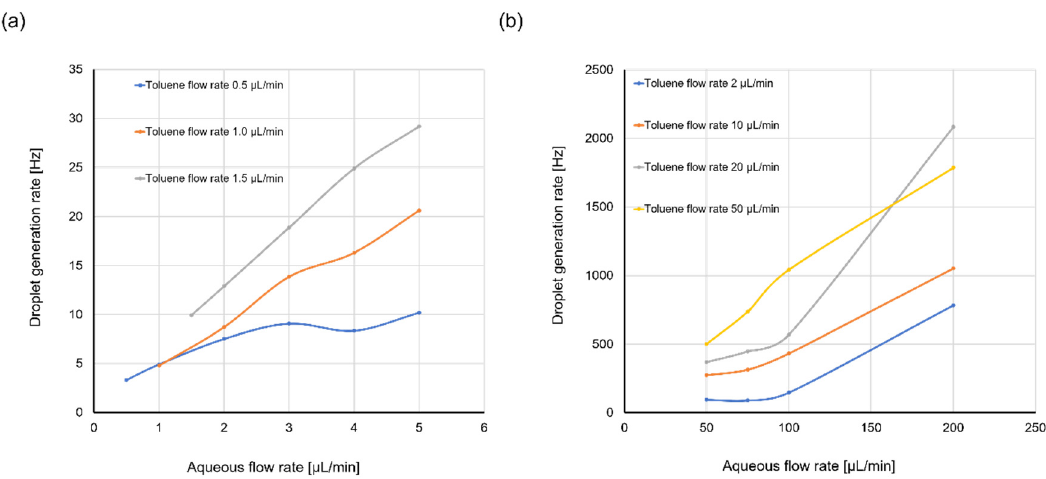
Figure 5. Variation in toluene droplet generation rate under different flow rates of dispersed phase (toluene) and continuous phase (water containing 4 wt % Tween 20). ( a ) The toluene flow rate was 0.5, 1.0, or 1.5 µL/min, and the aqueous flow rate was 0.5, 1.0, 1.5, 2.0, 3.0, 4.0, or 5.0 µL/min. ( b ) The toluene flow rate was 2, 10, 20, or 50 µL/min, and the aqueous flow rate was 50, 75, 100, or 200 µL/min.